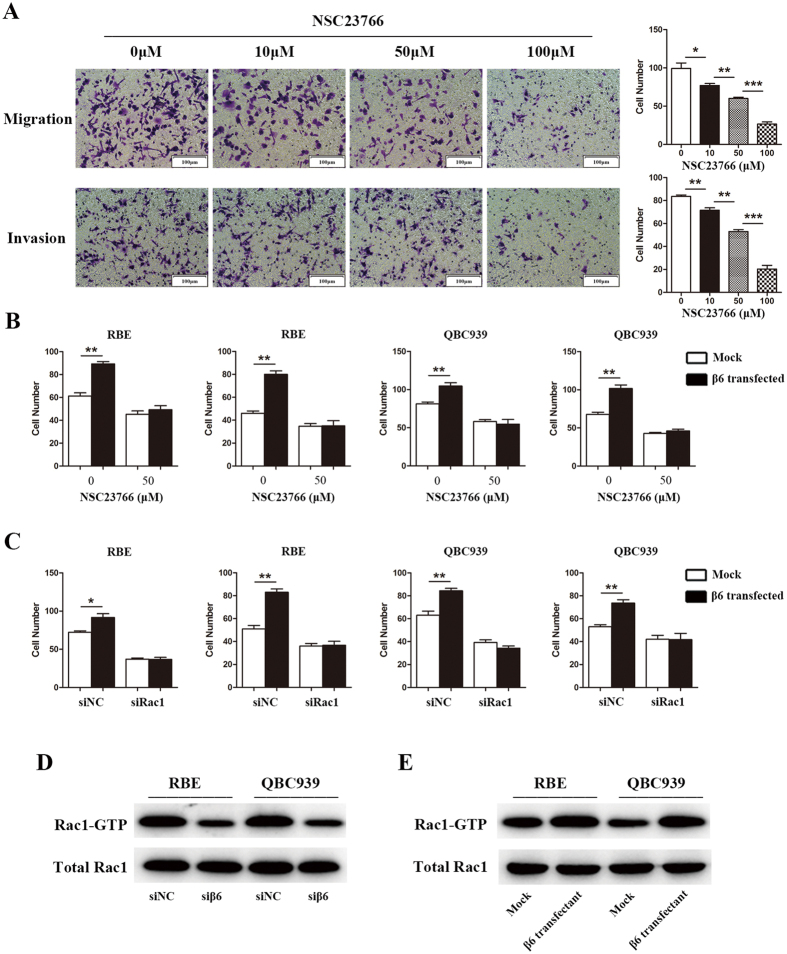
Integrin β6 promoted the invasiveness of cholangiocarcinoma cells by activating Rac1.(A) RBE cells treated with different concentrations of NSC23766, a Rac1 inhibitor, were used for migration and invasion assays. (B) After treatment with NSC23766, RBE and QBC939 cells were transfected with the β6-overexpressing plasmid, and the migration and invasion capacities were measured by Transwell assays. (C) RBE and QBC939 cells co-transfected with Rac1-specific siRNA and β6-overexpressing plasmid were used for migration and invasion assays. (D) After transfection with β6 siRNA or β6-overexpressing plasmid, cell lysates of RBE and QBC939 were used for PAK-GST pull down assays. Activated Rac1 as well as total Rac1 pulled down in the lysates were detected by western blot analysis. Data are shown as the mean ± SD, and the results shown are representative of 3 independent experiments. Five fields of cells in the lower compartment were counted in Transwell assays (200× magnification). *P < 0.05; **P < 0.01; ***P < 0.001.